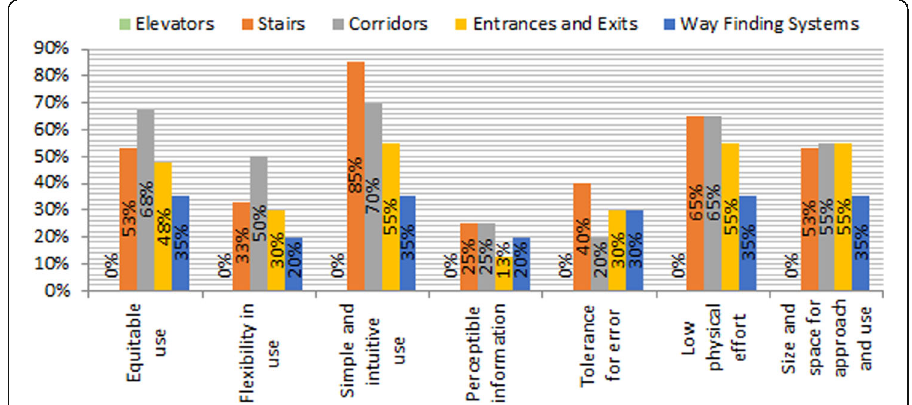
Fig. 26 Compliance of each element with each one of UD principles in building A “ the administrative building of the local unit of Aswan city